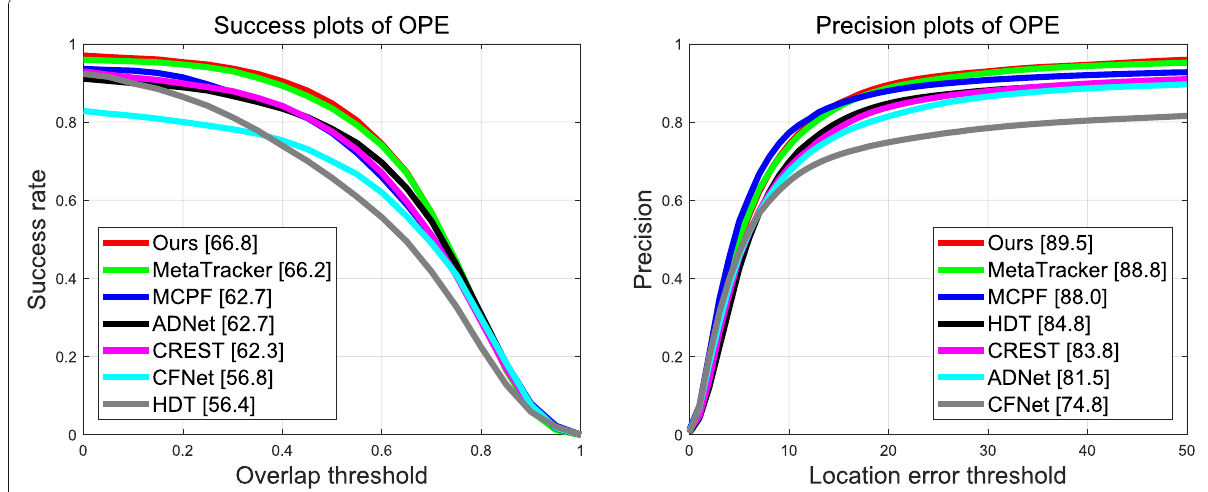
Fig. 4 Tracking results based on 11 attribute in terms of precision